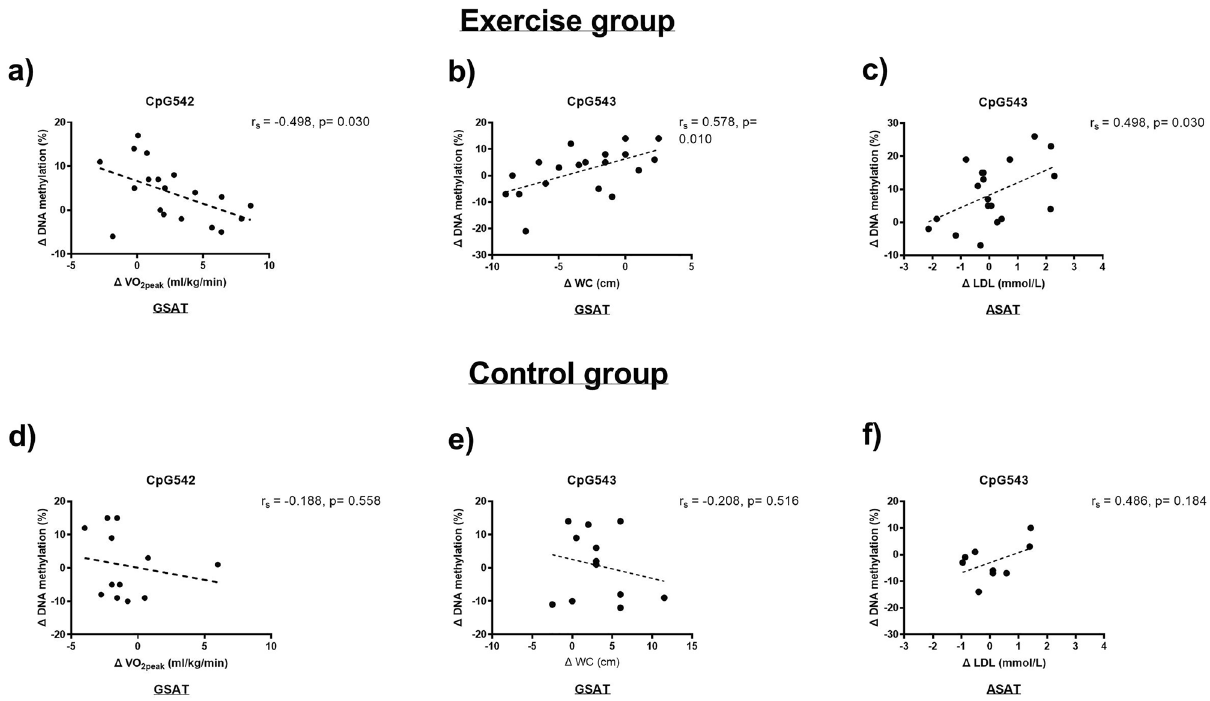
Figure 2. Spearman’s correlation analysis between changes in response to exercise training (Δ) in depot specific FKBP5 methylation and Δ VO 2peak ( a ) and Δ waist circumference (WC) ( b ) and Δ low-density lipoprotein (LDL) levels ( c ) (n = 12–19 per group). Linear regression lines used for descriptive purposes only. GSAT, gluteal subcutaneous adipose tissue; ASAT, abdominal subcutaneous adipose